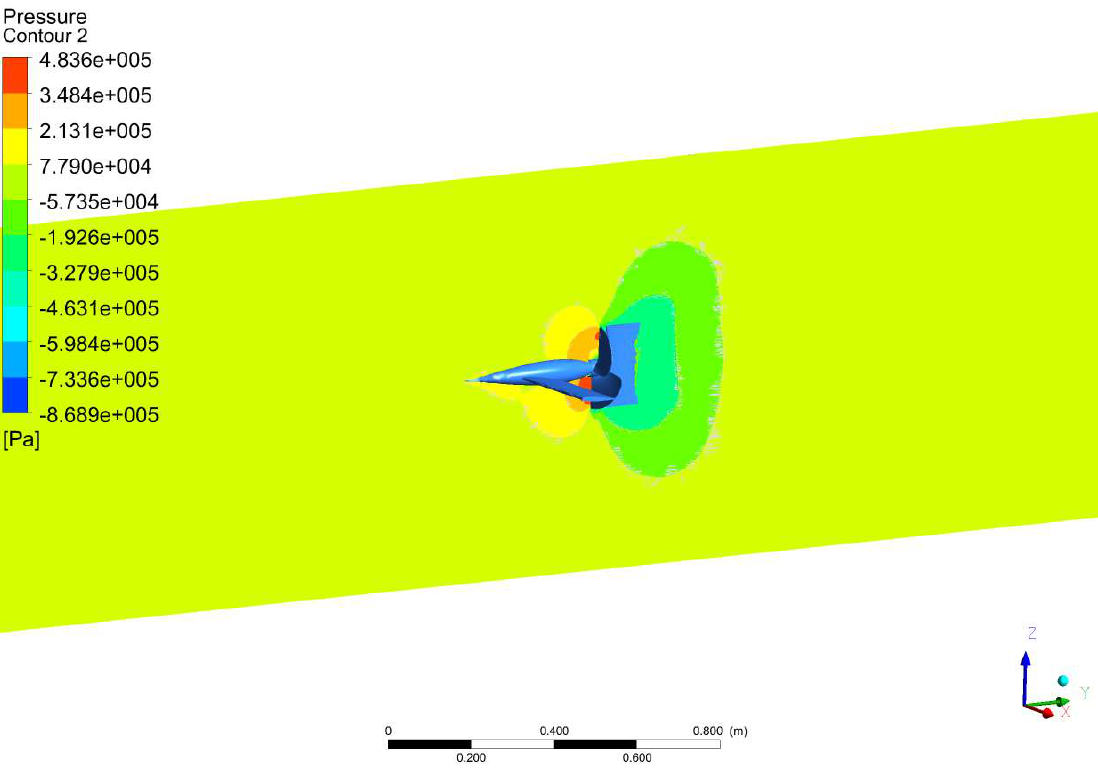
Figure 33. A typical view of Pressure distributions on US with rectangular wing.